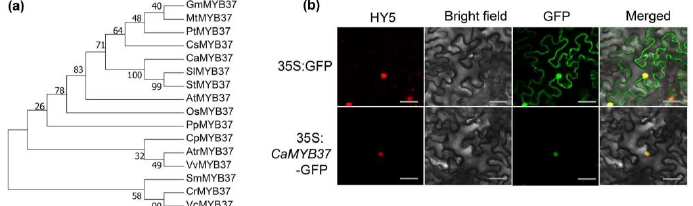
Figure 6. Phylogenetic analysis and subcellular localization of CaMYB37. ( a ) Phylogenetic analysis of amino-acid sequences of CaMYB37 in 16 plants. ( b ) Subcellular localization of the CaMYB37 protein in N. benthamiana leaves. Green fluorescent protein (GFP) signals indicated that CaMYB37 was localized in the nucleus. HY5 was used as a nuclear marker. Scale bar, 15 µ m.